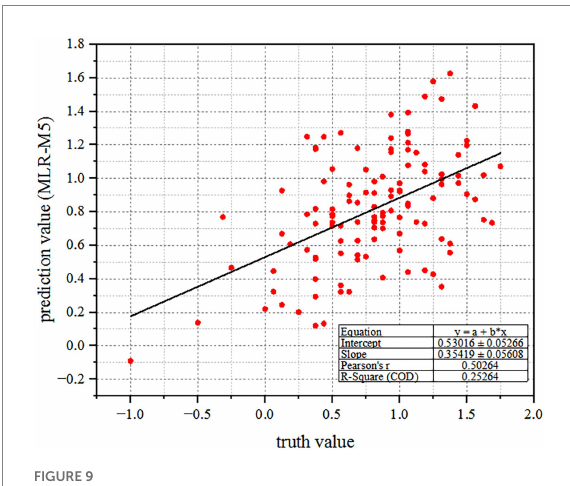
FIGURE 9 The scatterplot between the truth value and the prediction value. Among them, X -axis represents the truth value of color harmony, and Y -axis represents the corresponding prediction value by the proposed regression